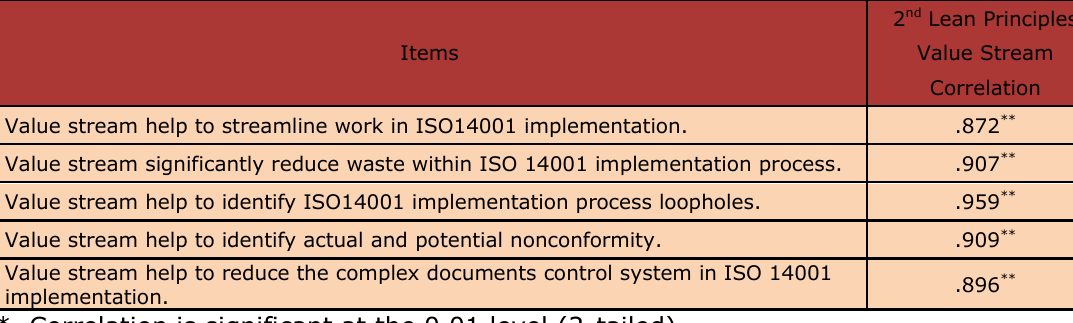
Table 7. Value Stream with ISO 14001 Requirements